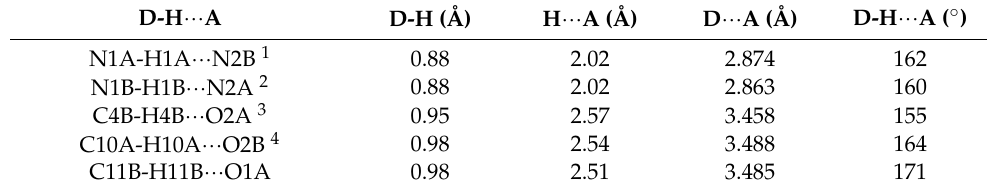
Figure 5. ( a ) Packing of P2 in the ac plane, detailing the supramolecular polymer formed by the hydrogen bonds between pyrazole cycles (blue broken lines). ( b ) View of the bc plane with details of the interactions involving the nitro group (red broken lines).